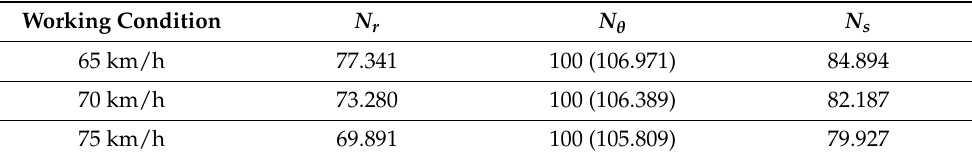
Table 9. Performance index scores of 65, 70 and 75 km/h serpentine tests without crosswind.